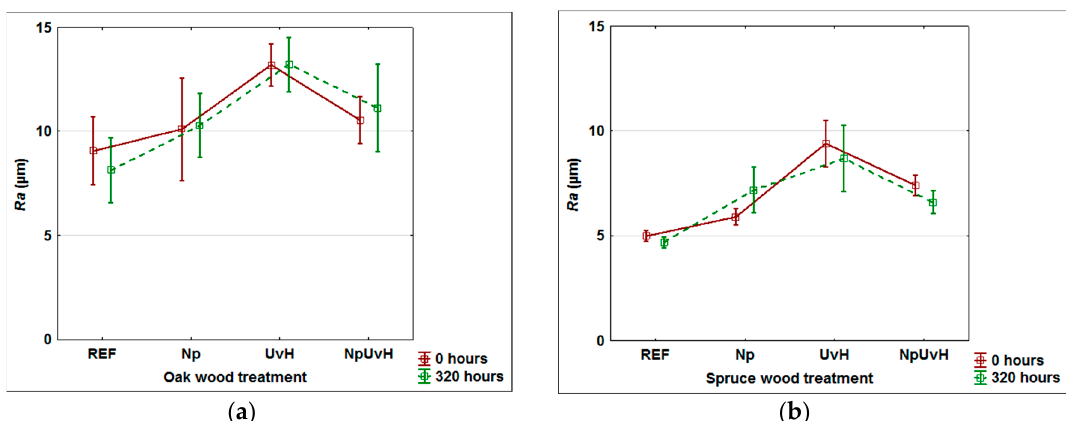
Figure 9. Surface roughness of oak ( a ) and spruce ( b ) wood before and after 320 h of artificial ageing. Reference (REF) without treatment; surfaces treated with water dispersion of nanoparticles (Np); surfaces treated with mixture of UV-stabilizers and HALS (UvH); surfaces treated with mixture of Np and UvH (NpUvH).